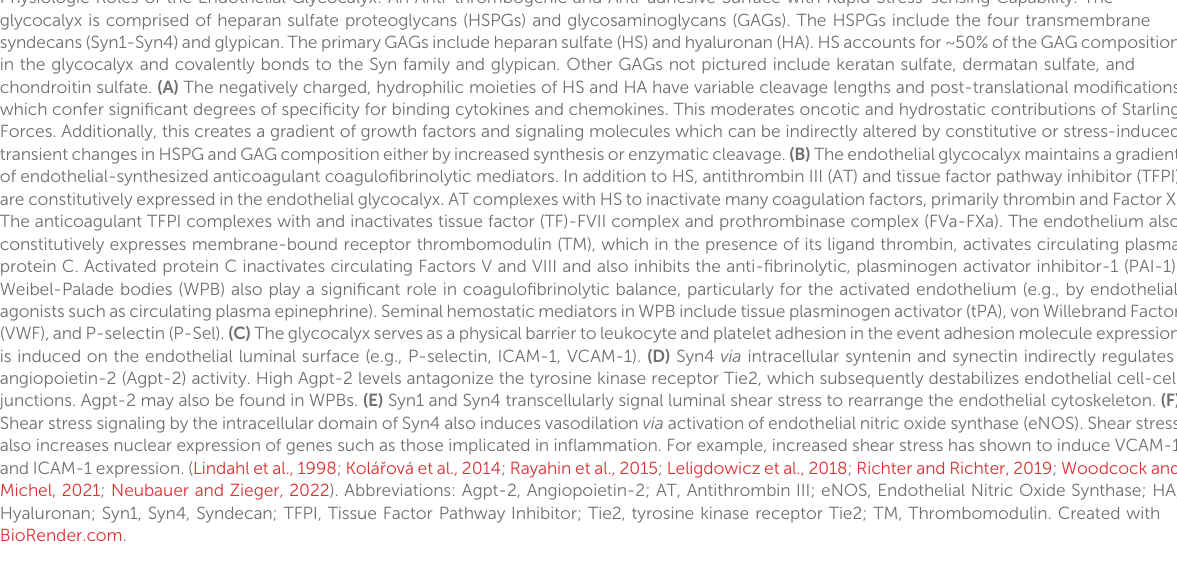
2007). Far from an inert layer of cells lining all blood and